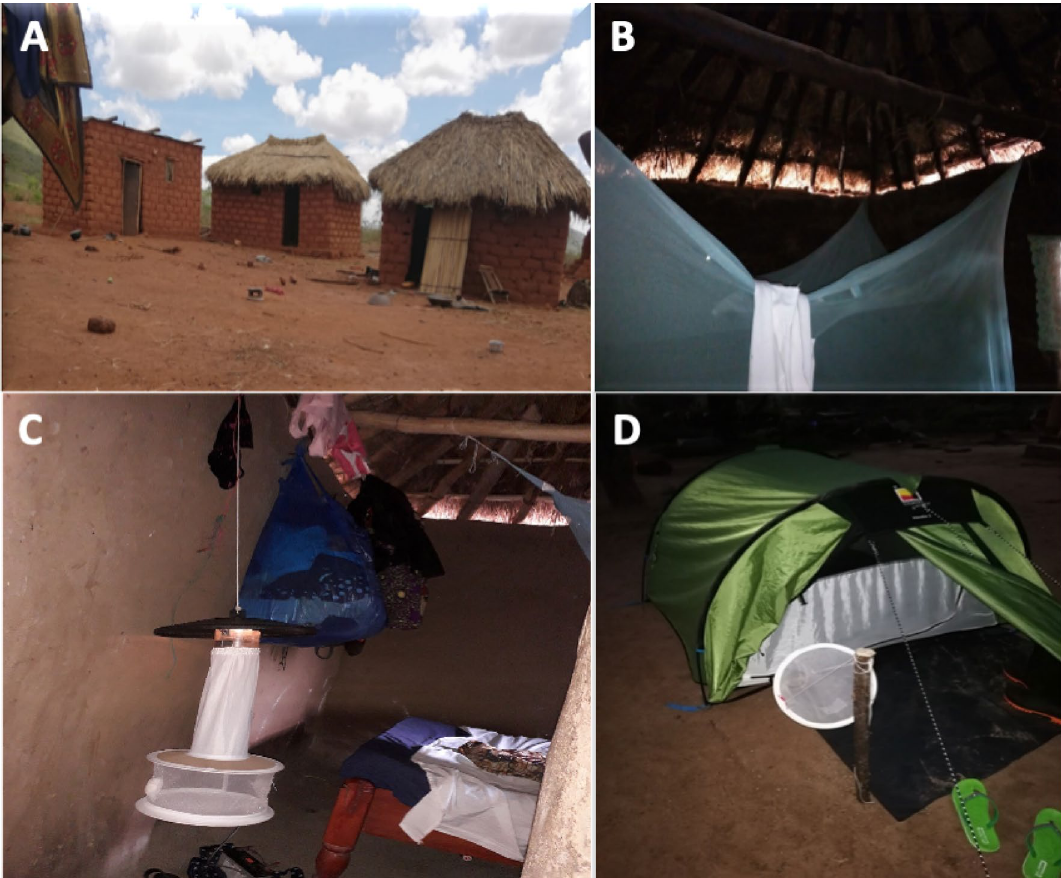
Figure 3. ( A ) Examples of different traditional house constructions, using local materials. ( B ) The inside of a typical house with open eaves. ( C ) A CDC-LT hung at the base of a sleeping space for sampling mosquitoes indoors. ( D ) A Furvela tent trap set up for catching host-seeking female Anopheles mosquitoes recently been reported from south-eastern Tanzania 25 ; however, our study indicates this shift in species composi- tion may not be restricted to the south of the country. Around Lake Victoria, species abundance and transmission intensity vary quite considerably spatially and temporally 28 , with implications for the deployment of effective malaria vector control interventions. These het- erogeneities likely reflect differences in climatic conditions such as rainfall and ecological settings, which sup- port the breeding of particular vector species 29 . In our study, overall vector densities were significantly higher in villages located in the southern part of the study district compared to the northern clusters. An. gambiae s.s. and An. arabiensis occurred across Misungwi district, however, An. gambiae s.s. abundance was lower in the South and concentrated mostly in the North. By comparison, An. funestus s.s. was equally distributed throughout the district in sympatry with An. arabiensis and An. gambiae s.s. but found at the highest densities along shorelines and waterways feeding into Lake Victoria. The spatial variation of Anopheles sibling species may be explained by several factors linked to ecological features, including turbidity, water quality, relative humidity, temperature, vegetation type and/or socioeconomic parameters, such as ownership and usage of insecticide-based vector control measures and livestock density, as observed in previous studies conducted on the Kenyan side of Lake Victoria 34 . An. gambiae s.s. are known to breed in rain-dependent temporary habitats 35 , while An. funestus s.s. and An. arabiensis can colonize large permanent aquatic habitats, some with large vegetation, in arid and highland areas 36,37 . Most residents in Misungwi district, especially in the southern clusters, traditionally stored rainwater for domestic purposes and animal husbandry in large, permanent man-made pools, locally called “Rambo”, which were filled throughout the year and could serve as potential breeding sites for An. funestus s.s. and An. arabiensis , even in the dry season; the higher density of An. gambiae s.s. during the rainy season is likely due to increased availability of temporary breeding sites 38,39 . In addition, agricultural practices such as irrigated rice paddies create diverse aquatic mosquito breeding habitats that could influence the co-existence and abundance of different vector species in the study area 40,41 . An. funestus s.l. was collected in both seasons but peaked during the dry season, consistent with its ability to develop in habitats that can sustain desiccation 42 . Of concern, both An. gambiae s.l. and An. funestus s.l. malaria vector species were present during different seasons, favoured by distinct climatic and ecological conditions, sustaining malaria transmission throughout the region and the year. Of all mosquitoes sampled in this study, Culex species were the most abundant, contributing to 67.6% of the